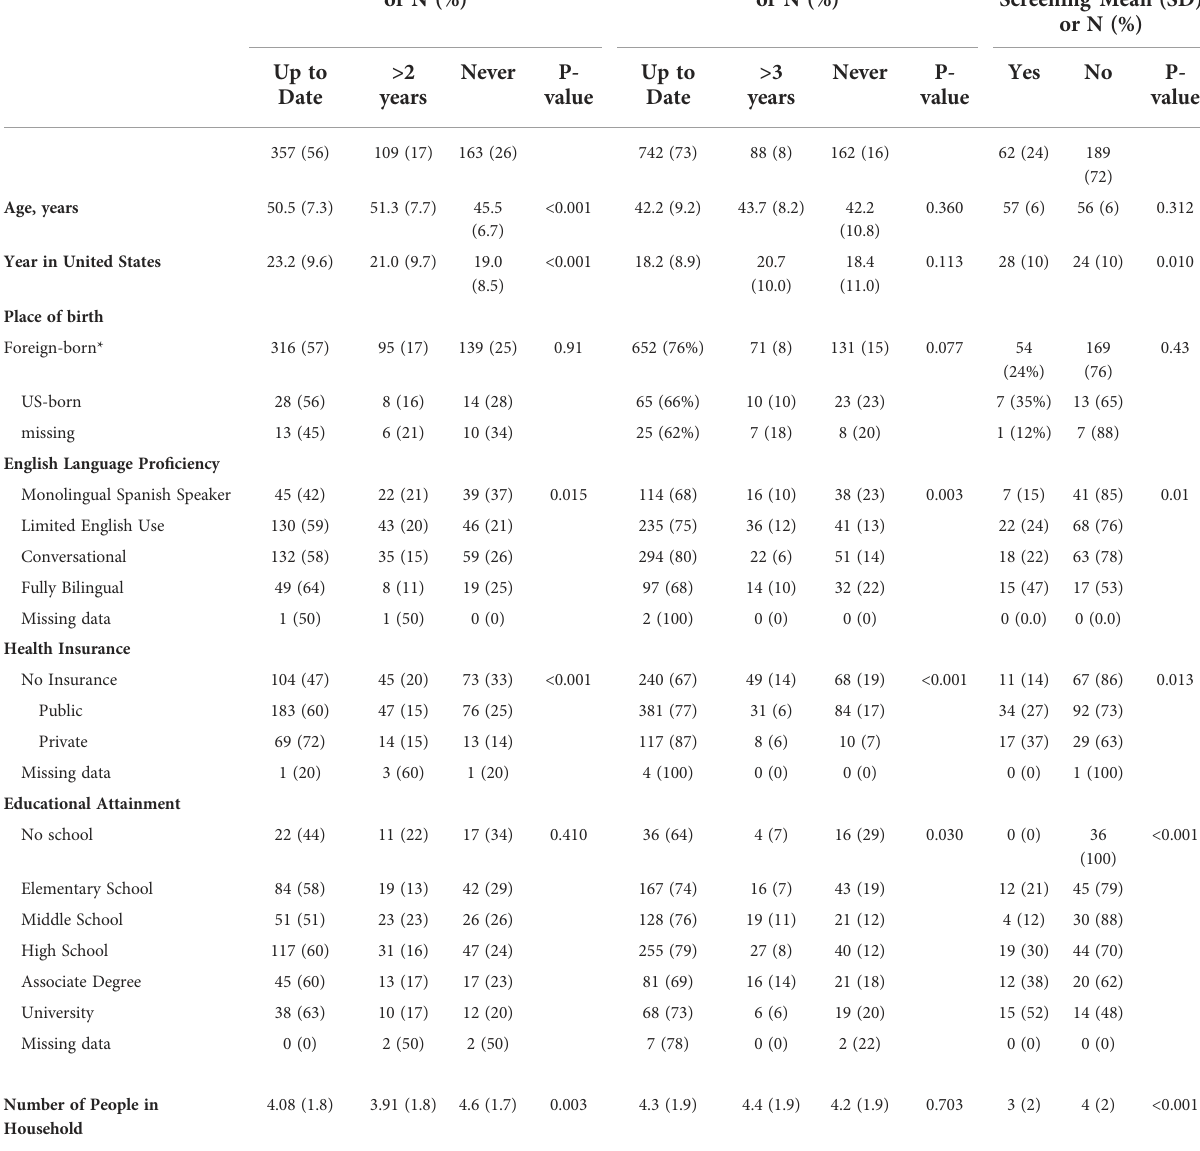
TABLE 3 Cancer Screening behavior among ‘ Tu Historia Cuenta ’ study participants by demographic variables.